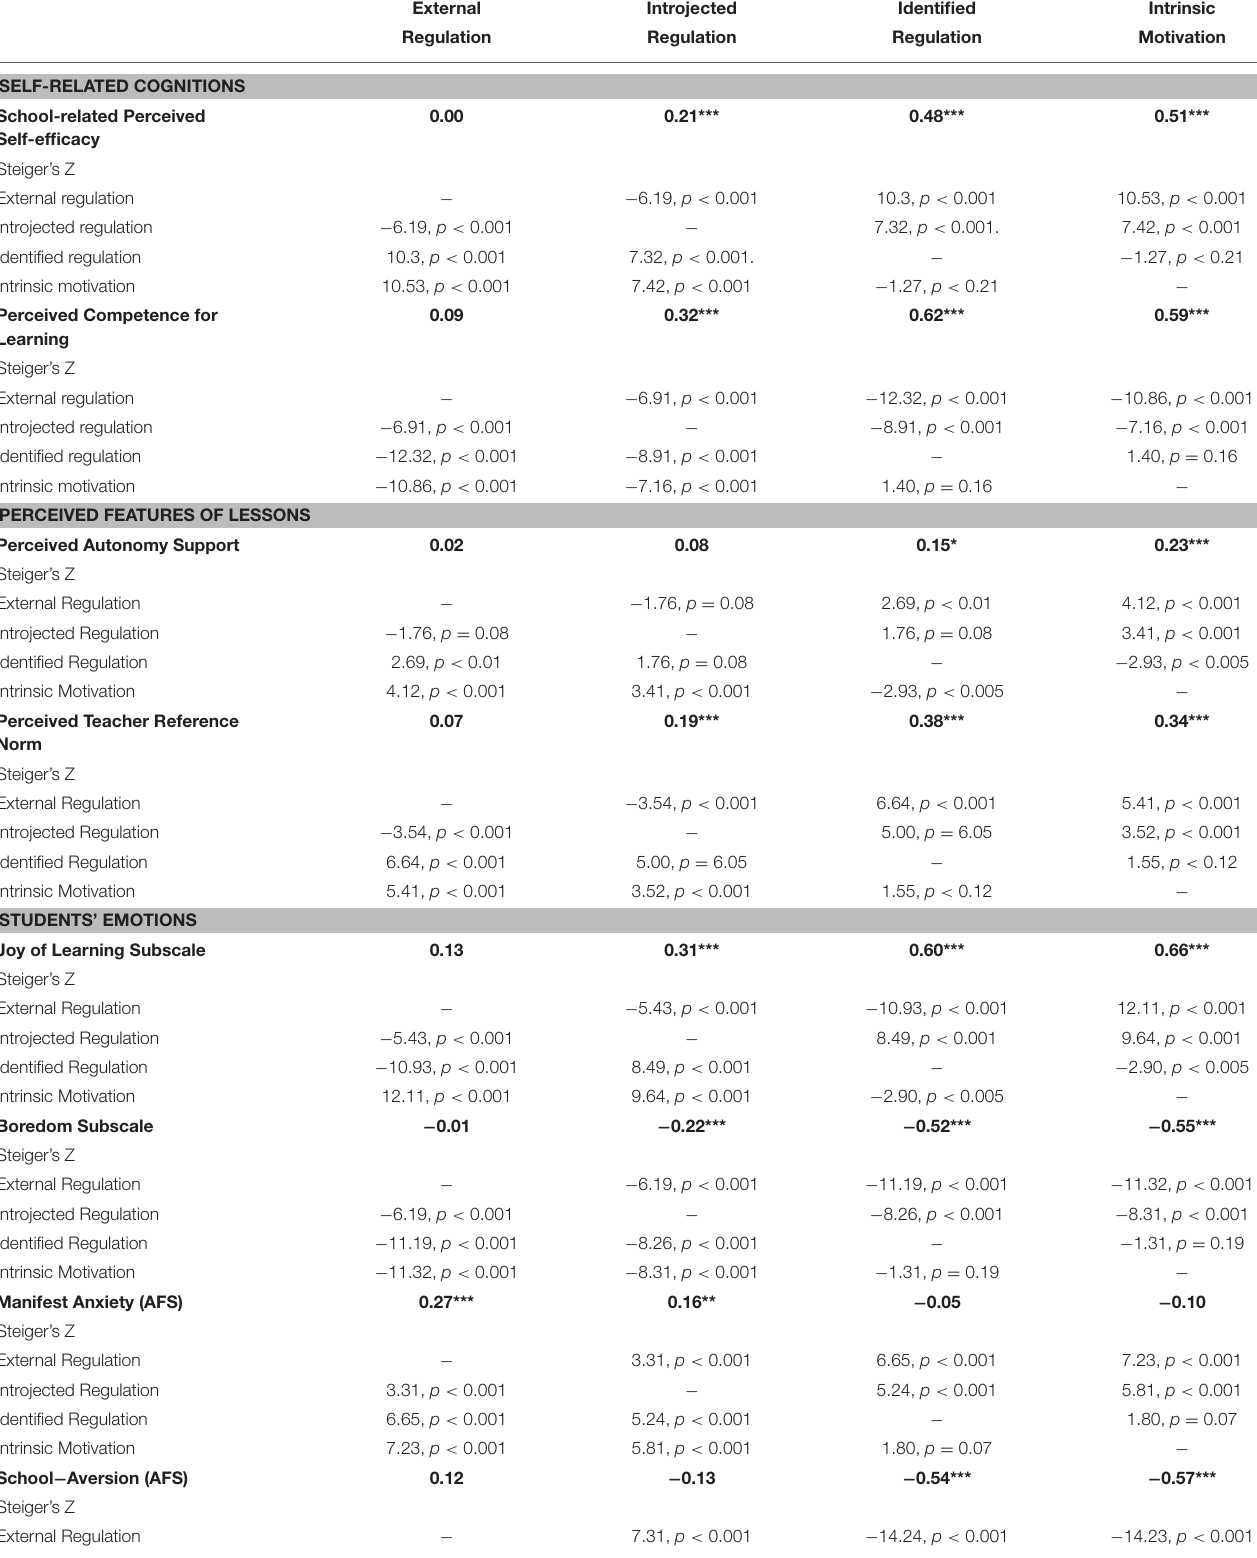
TABLE 6 | Pearson correlation coefficients among the four scales of the German version of the 28-item SRQ-A and several indices of self-related cognitions, perceived features of lessons, and students’